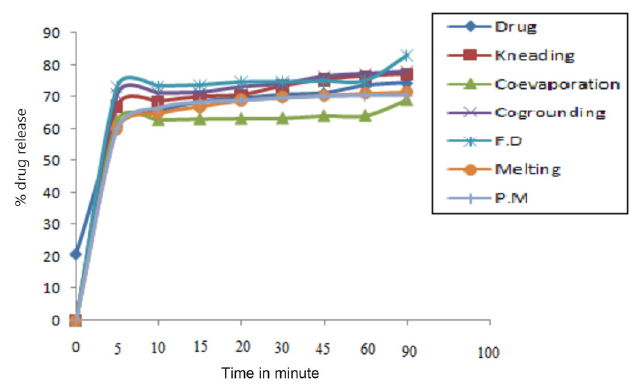
FIGURE 6 - Drug release of the drug and its complexes in 0.1 N HCl.